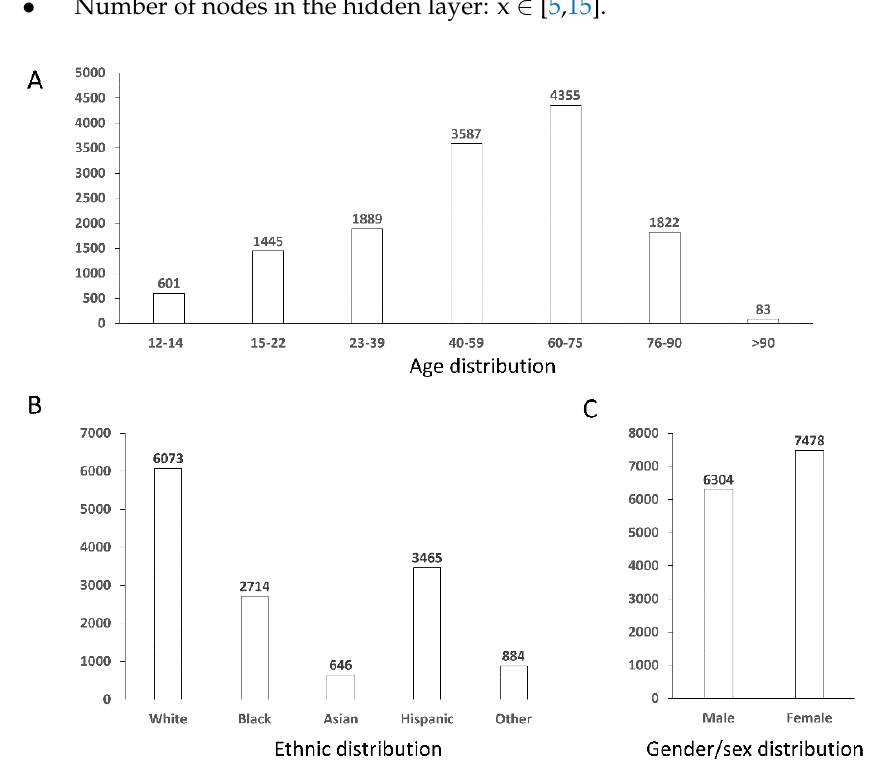
Figure 1. Distribution graphs for the population of the final dataset. Panel ( A ) reports distribution by age ranges, panel ( B ) by ethnic groups, and panel ( C ) by gender/sex.